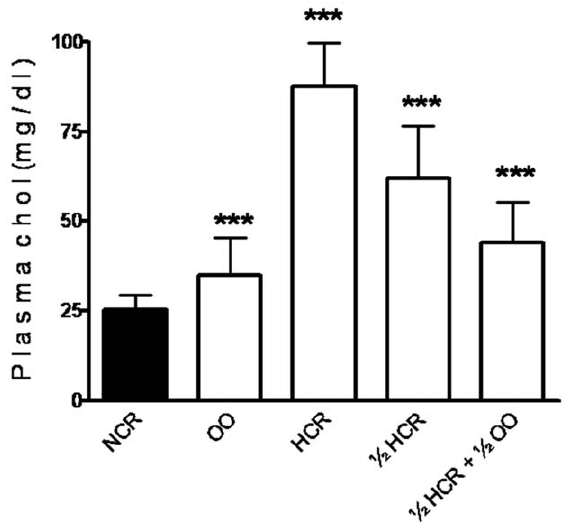
Figure 2. Effect of diet on blood cholesterol. Bars represent the mean 6 SEM of plasma cholesterol concentration from NCR, OO, HCR, K HCR and K HCR + K OO during the last 3 months of experiment. n=45 samples. *** indicates significantly different from NCR (p , 0.001).